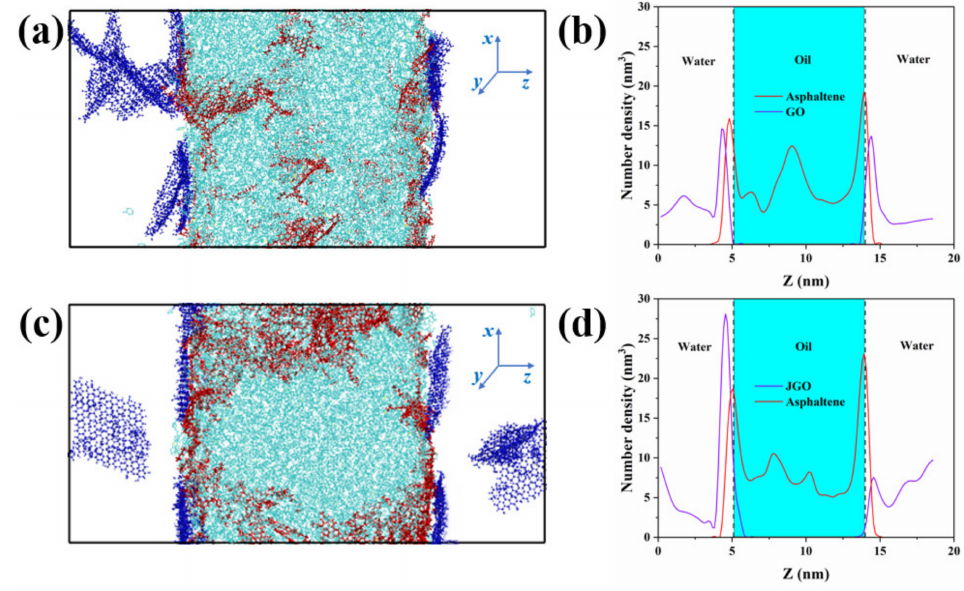
Figure 7. Final simulation configuration (at 50 ns) of GO ( a ) and JGO ( c ) in the oil/water system. Oil components are colored in cyan except asphaltene which is colored in red, and GO and JGO are colored in blue. Water molecules are not shown for clarity. Number density of three asphaltene in oil, GO ( b ), and JGO ( d ) along the z-direction. Gray dash lines in ( b , d ) represent the Gibbs partition surface.